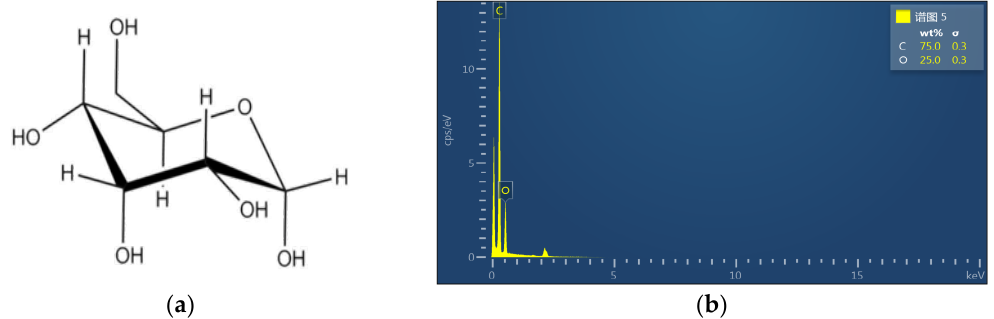
Figure 5. Molecular formula of cellulose ( a ) and EDS of the untreated pressboard ( b ).